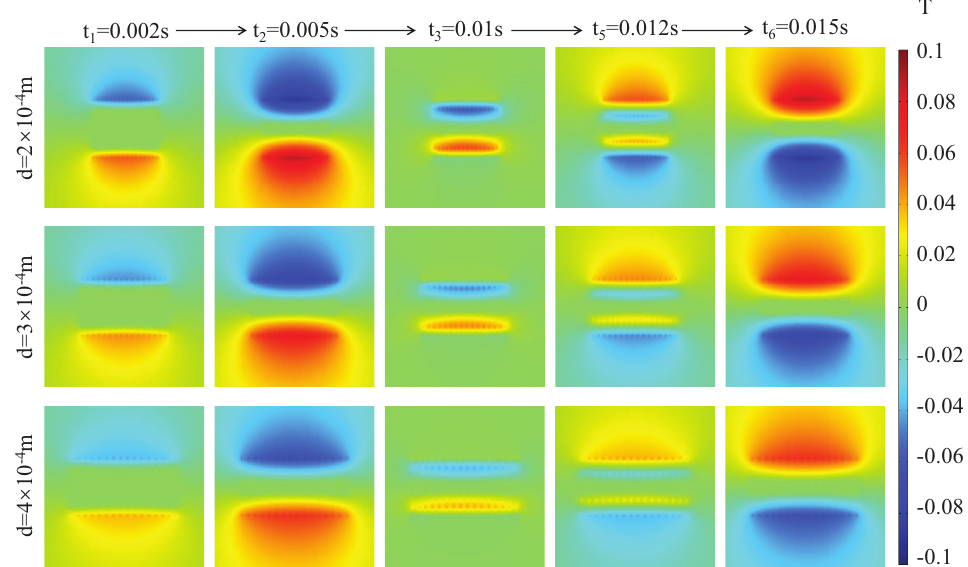
Figure 10. Distribution of perpendicular magnetic field around the coil in one cycle (I max = 70 A).